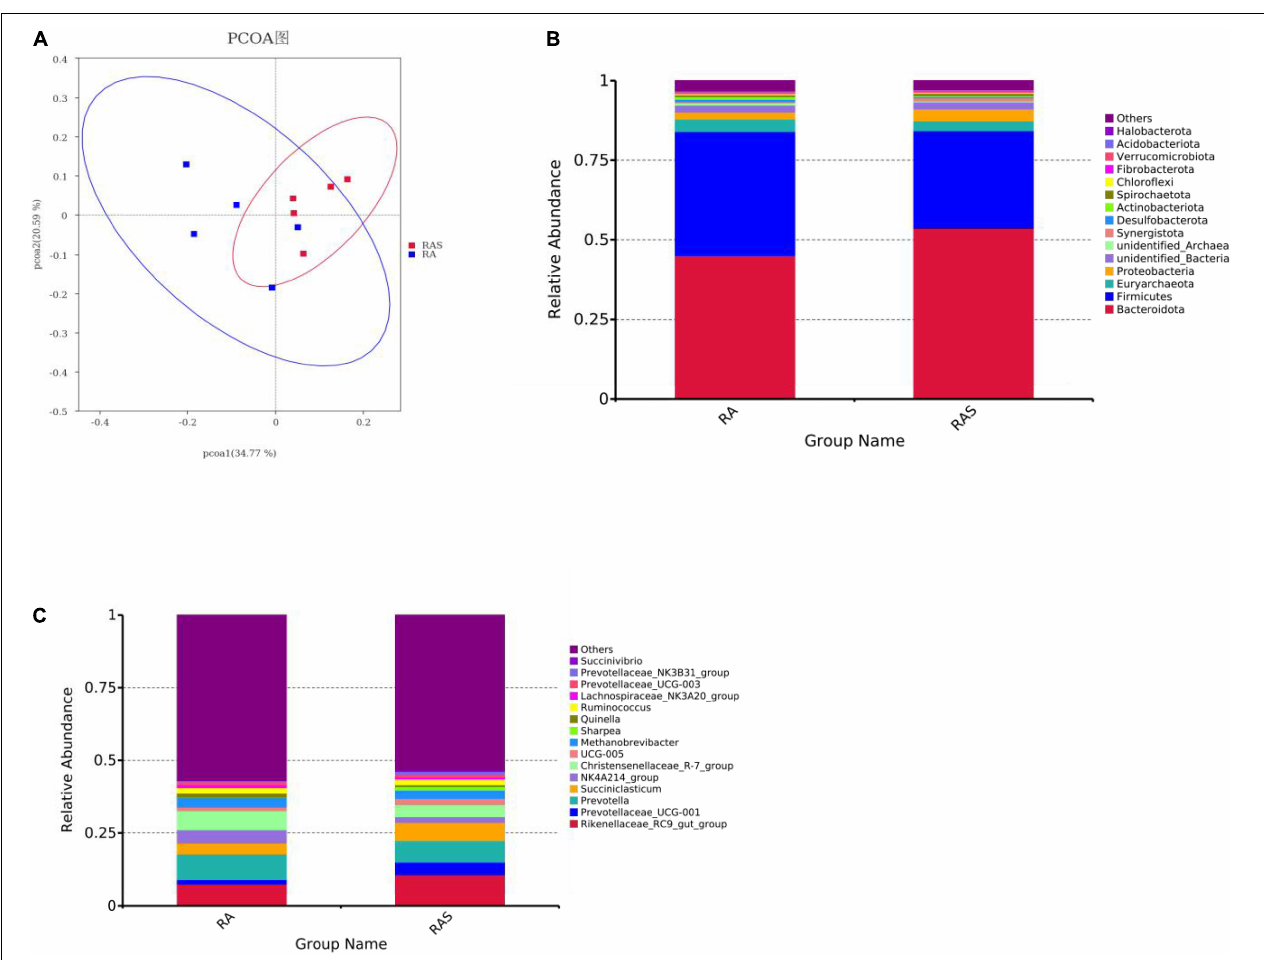
FIGURE 1 | (A) Diversity analyses based on the ruminal microbiota; phylum (B) and genus level (C) composition of the ruminal bacteria (top